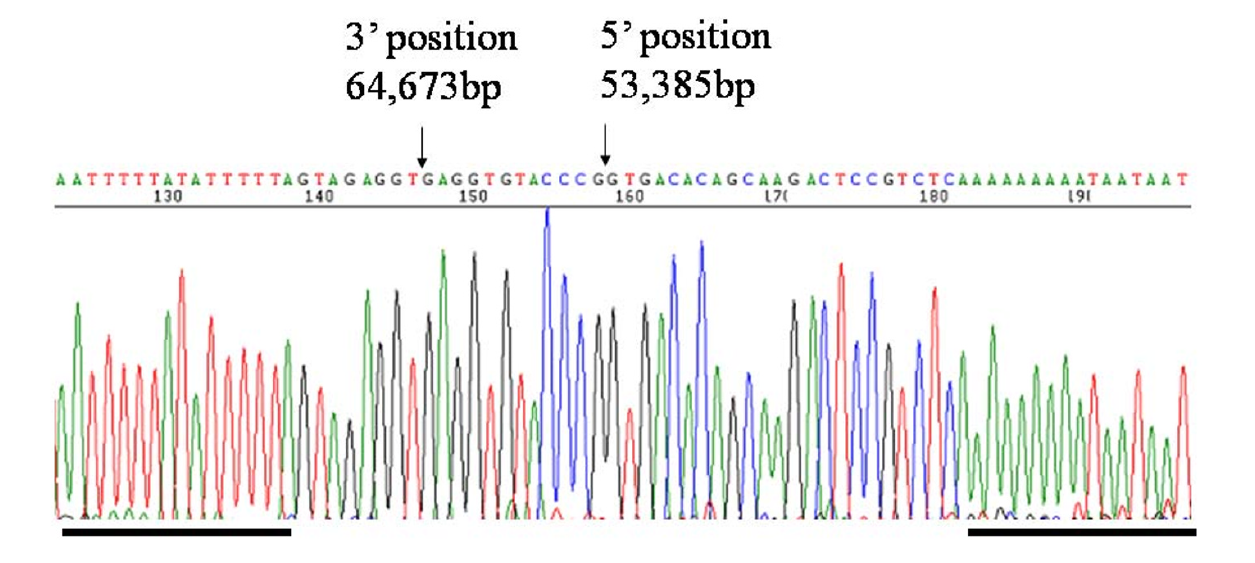
Figure 3 Sequence of deletion breakpoint in the NDI family . 5'and 3' breakpoints at positions 53,385 and 64,673 bp, respectively, relative to the published sequence (GenBank U52112.2) are indicated with arrows. The sequence is shown in antisense orien- tation. There is an insertion of the "GAGGTGTACCC" sequence in the break point. Bold lines indicate palindromic sequence which could cause the interstitial